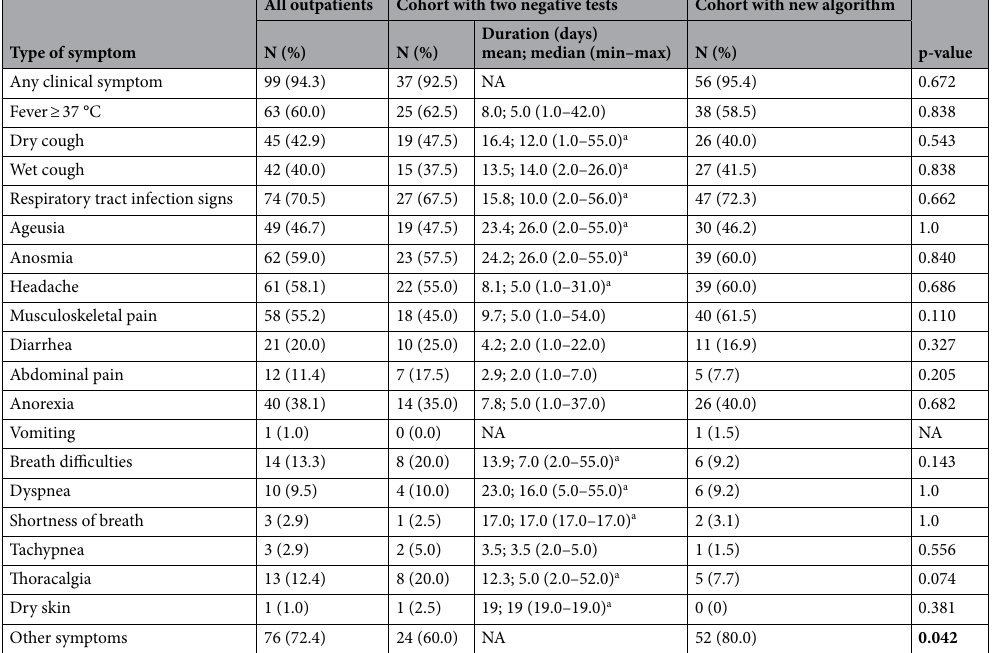
Table 4. Incidence and duration of COVID-19 symptoms in outpatients. COVID‑19 coronavirus disease-19, NA not applicable. a Symptom continued on the last phone call at least in one patient. Telemonitoring was ended due to double PCR negative